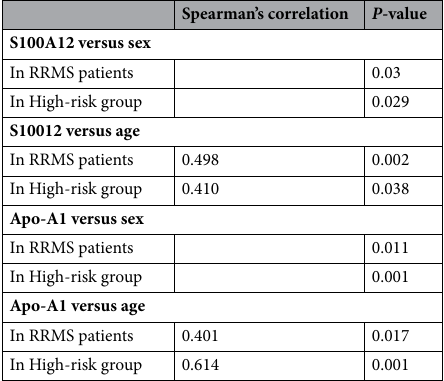
Figure 4. The plasma concentration of S100A12 showed a positive correlated with the age in the untreated RRMS group (Spearman; r = 0.498 and P = 0.002) ( A ), and in the high-risk (Spearman; r = 0.410 and P = 0.038) ( B ). Apo-A1 plasma level also revealed a positive correlated to the age in both untreated RRMS and in the high- risk groups (Spearman; r = 0.401 and P = 0.017) ( C ), (Spearman; r = 0.614 and P = 0.001) ( D ) respectively. Spearman’s correlation P